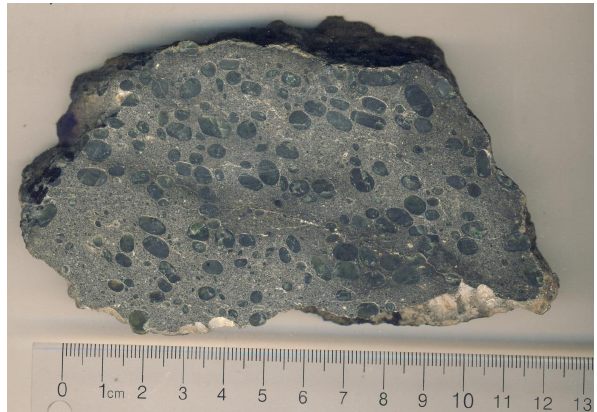
Figure 2. Xenocrystic olivine grains within Igwisi Hills lava sample IH53. High-resolution scan of polished slab of lava sample showing abundance, distribution and highly ellipsoidal shapes of xenocrystic olivine. Fig. 2 [Jones et al., Solid Earth, 2014]